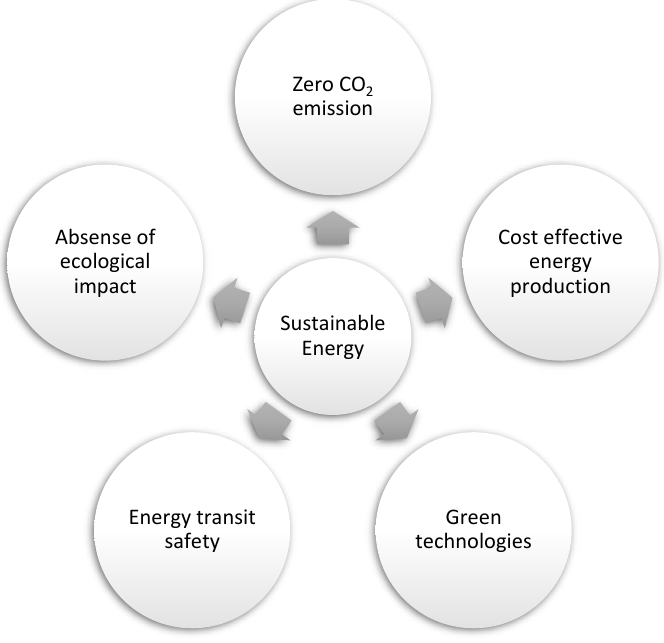
Figure 1. Five significant targets of sustainable energy.